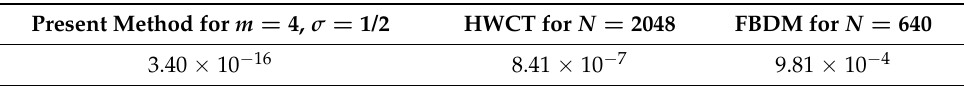
Table 5. Comparison of the maximum absolute errors between the present method, the HWCT [46], and the FBDM [55].